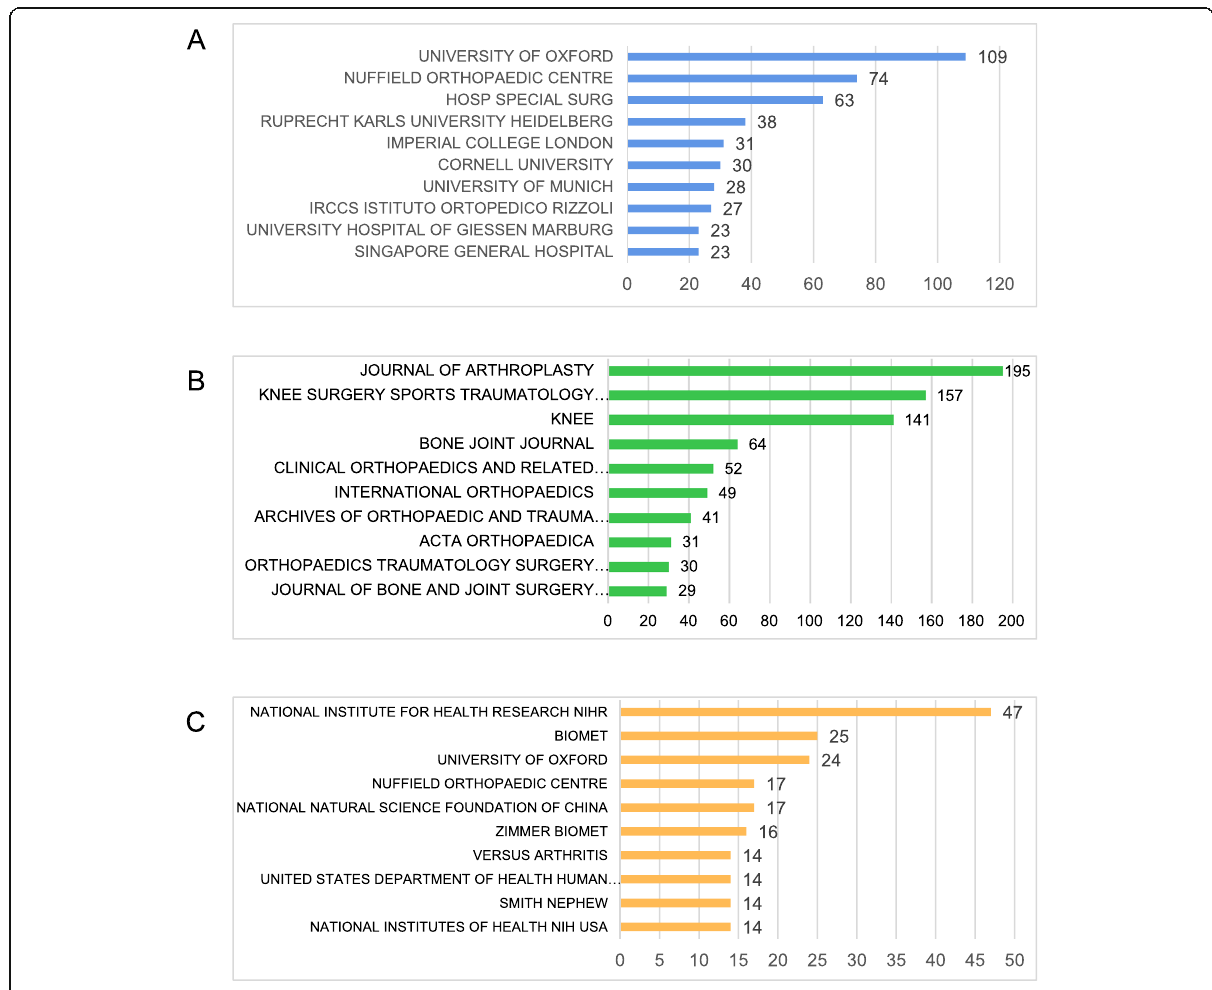
Fig. 3 a : UKA publication: Top 10 institutions by publication volume; b : Top 10 journals by publication volume; c : Top 10 funding